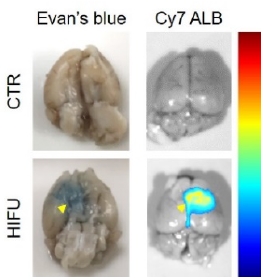
Figure 3. HIFU with microbubbles disrupts the BBB detected by accumulation of Evan’s blue (left panel) and Cy7-albumin (Cy7 ALB, right panel). Arrowhead, accumulation of Evan’s blue (EB) and Cy7-albumin (Cy7 ALB) in the brain of mice after HIFU.